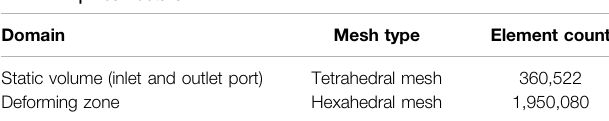
Figure 4 , and the average pressure at this plane monitored through the simulations; higher the pressure variation, higher will be the fl uid-borne noise of the pump.